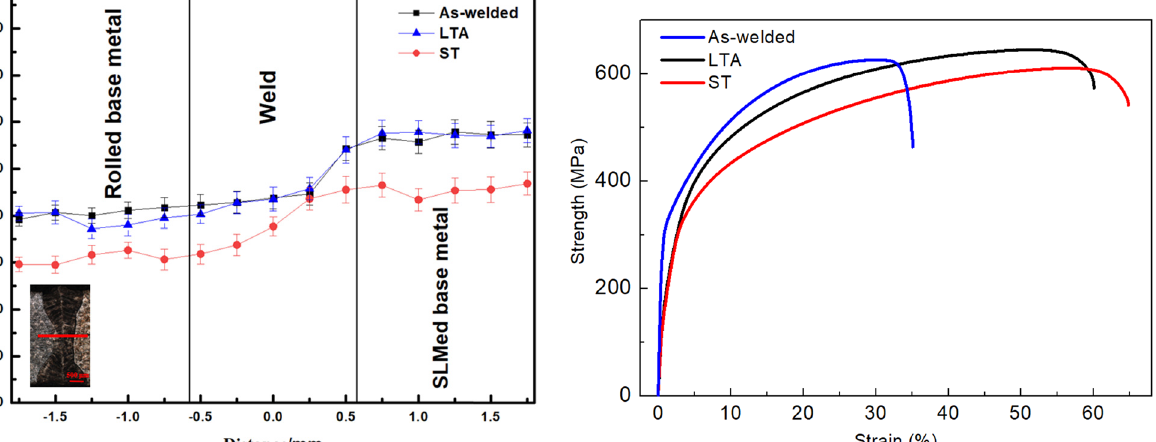
Figure 8: Microhardness distribution of laser - welded joints. Figure 9: Tensile test results of heat - treated